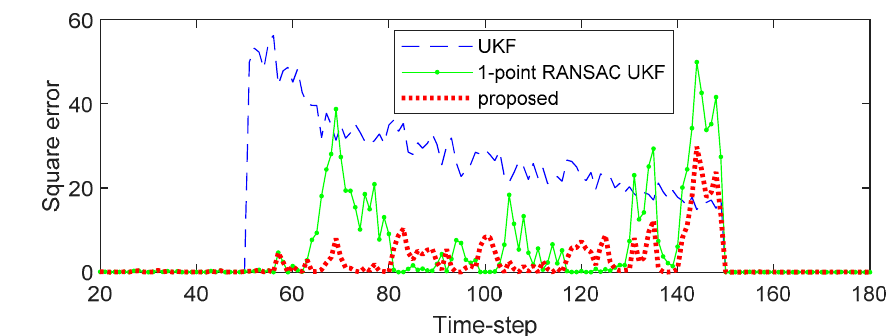
Figure 2. The estimation results of the simulation.